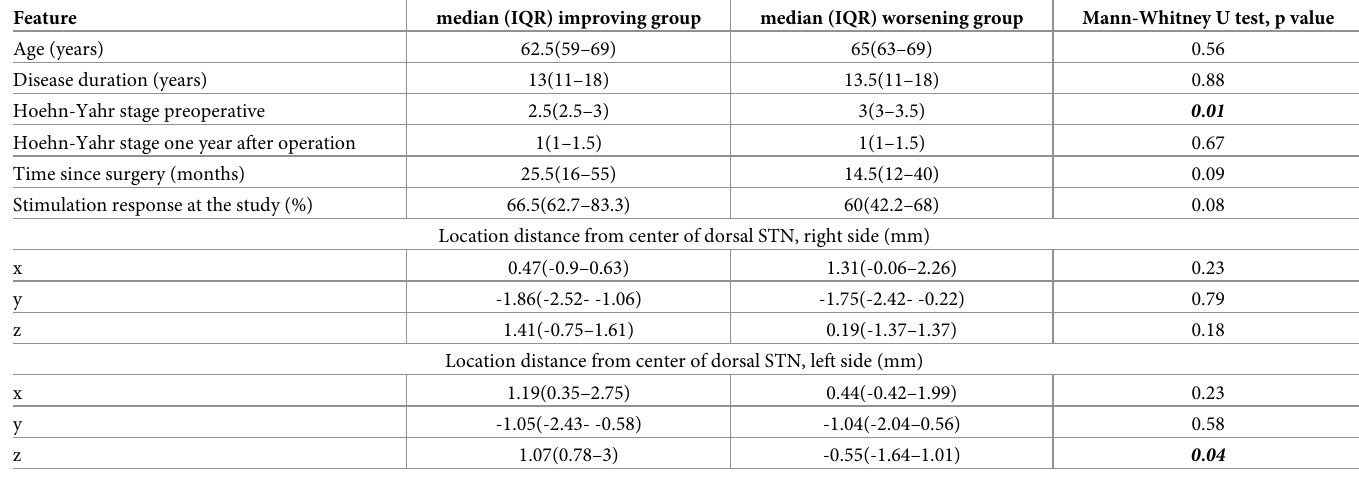
Table 3. Comparison of factors in the patients’ subgroups with improving and worsening balance with stimulation ON.